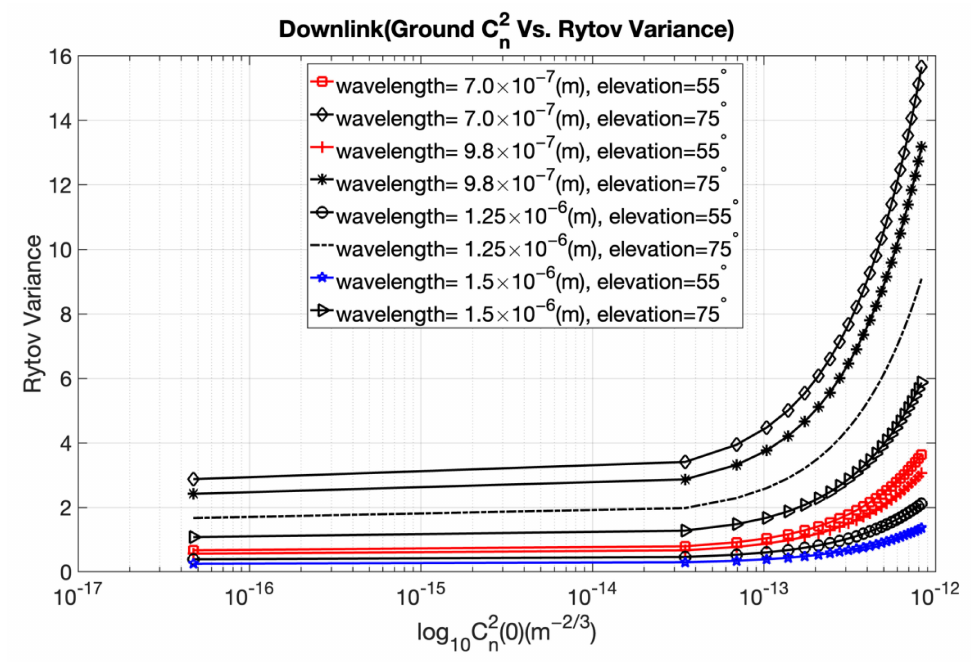
Figure 5. Variation in the Rytov variance in a downlink